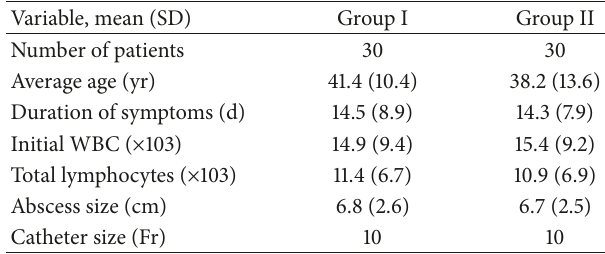
Table 1: Comparison of preadmission variables among treatment groups.